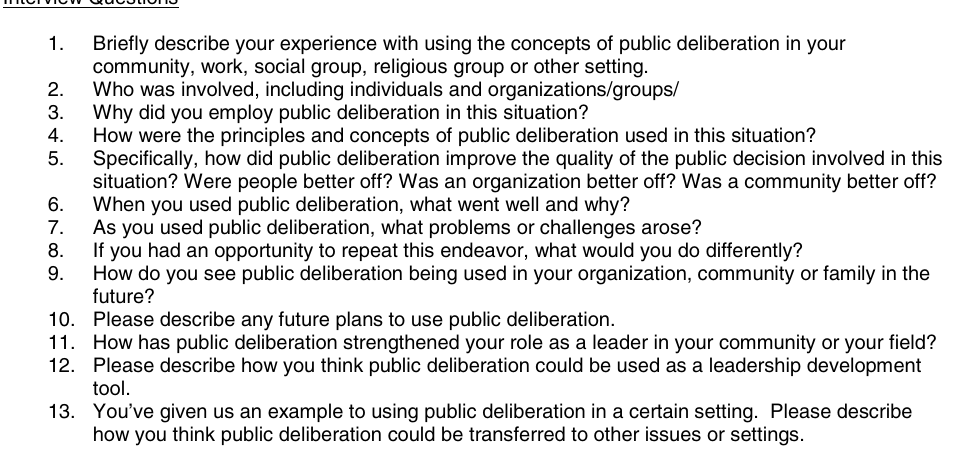
Table 1. 13-Item In-depth Interview